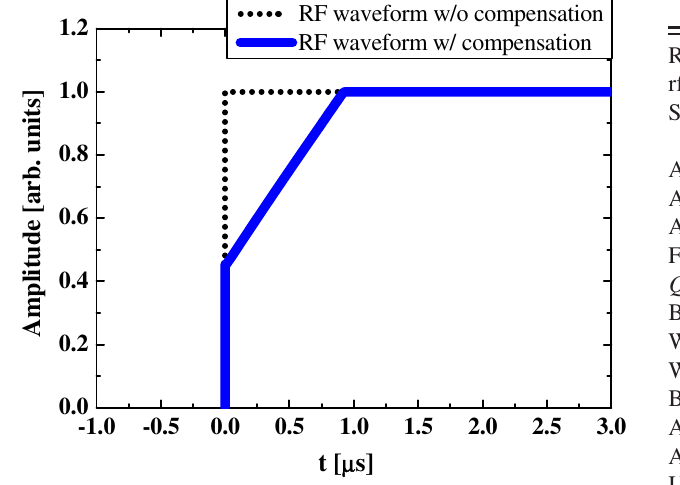
FIG. 12. (Color) Modulated rf waveform for energy spread compensation (solid blue line) and ordinary rectangular wave- form profile (dotted black